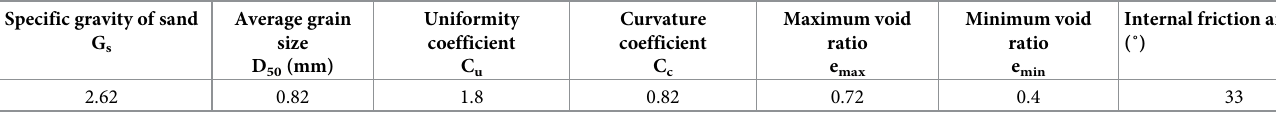
Table 2. Geotechnical indices of standard sand.